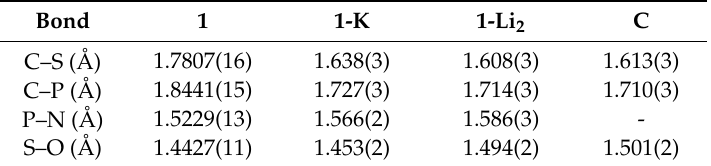
Table 1. Comparison of structural parameters (average values for S–O bonds, 1-K and 1-Li 2 ). Bond